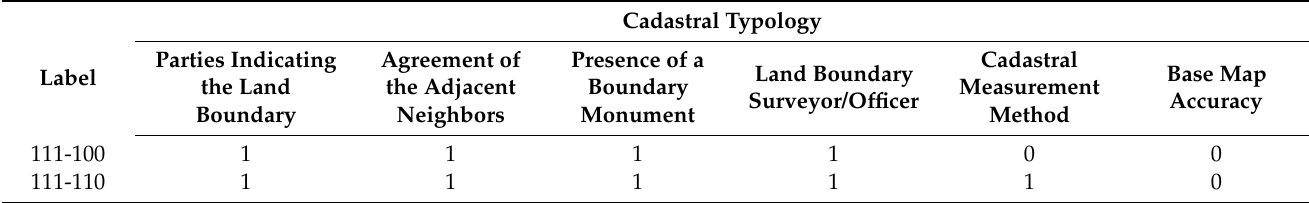
Table 4. Example of labeling of Typology of Cadastre of a land